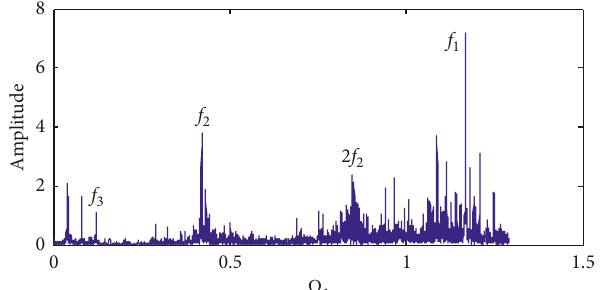
Figure 16: Dimensionless test signal frequency spectrum.